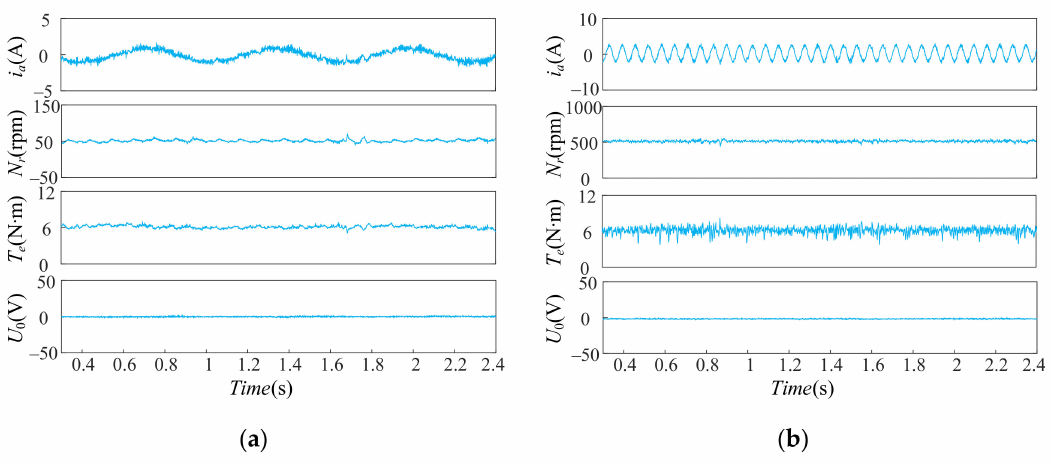
Figure 8. Experimental results in a steady-state with a 6 N · m torque command: ( a ) 50 rpm speed command; ( b ) 500 rpm speed command.